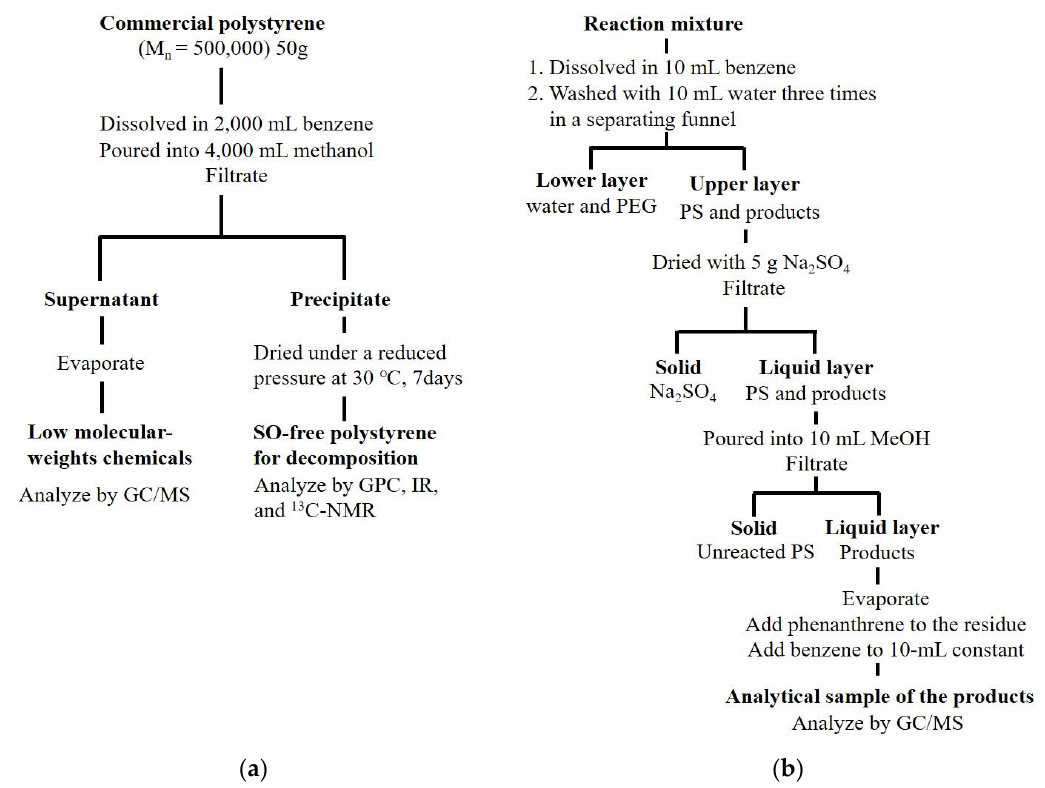
Figure 1. Procedure for purifying ( a ) styrene oligomers (SO)-free polystyrene (PS) and ( b ) subsequent treatment.